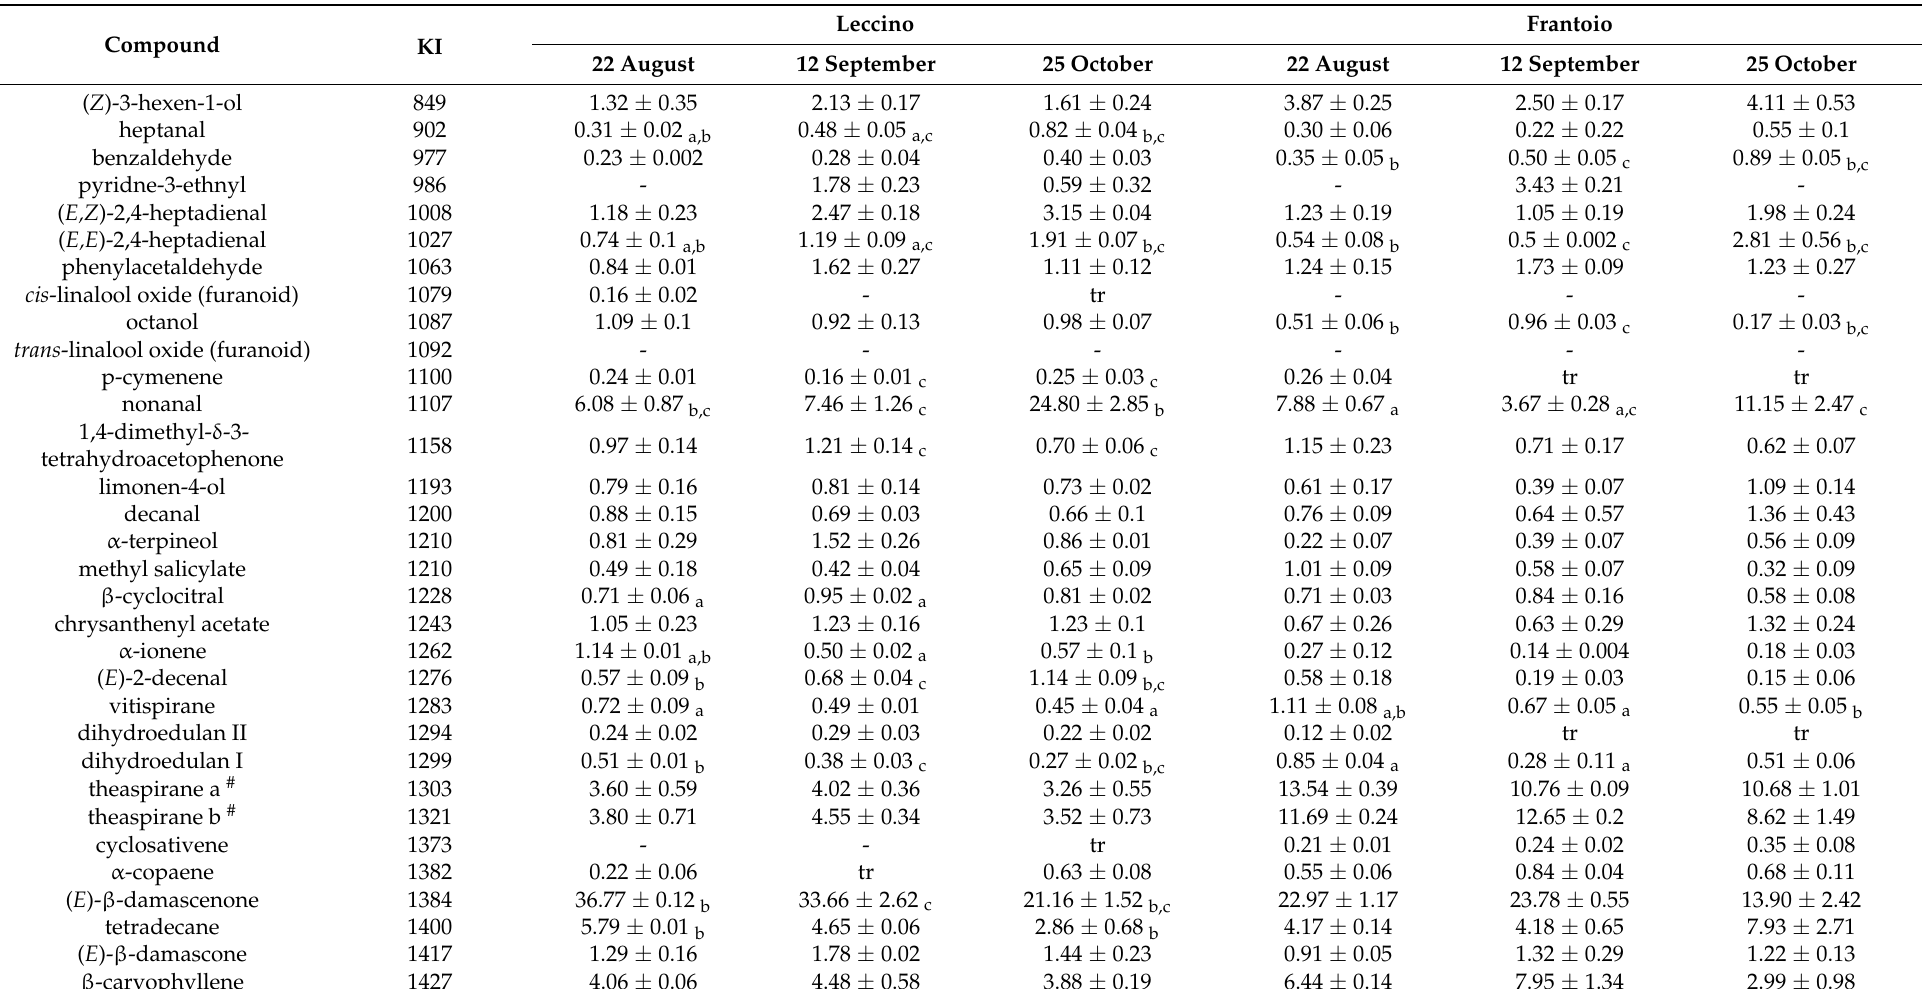
Table 2. Composition of volatiles identified at different harvest periods in essential oils of olive leaves from cvs. Leccino and Frantoio.